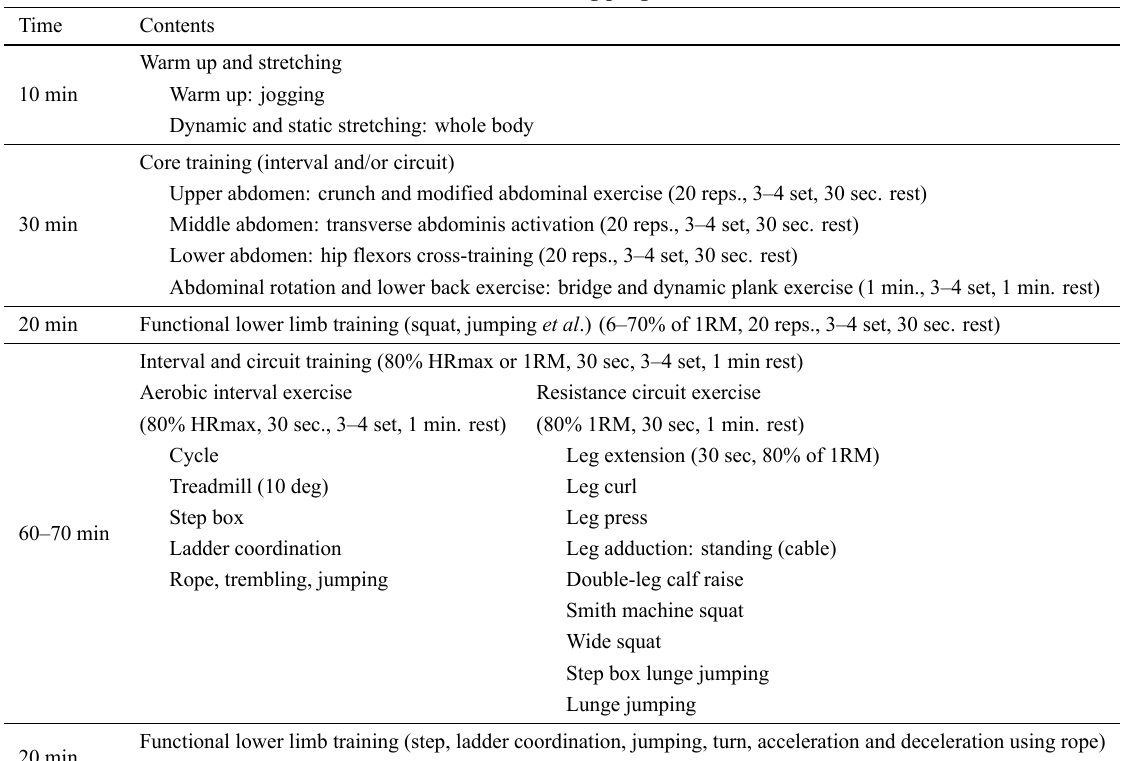
Table 1. Training program.